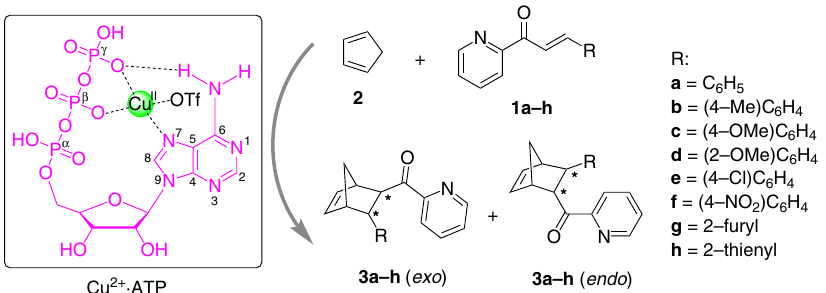
Fig. 1 Schematic representation of enantioselective Diels – Alder reactions catalysed by a Cu(II)-ATP complex. The Cu(II) – ATP complex (Cu 2 + ·ATP) is composed of copper(II) tri fl uoromethanesulfonate (Cu(OTf) 2 ) and ATP. The coordination structure of Cu 2 + ·ATP is supported by spectroscopic characterisations and theoretical calculations, in which Cu 2 + ion binds to one nitrogen atom (N7) from adenine, one oxygen atom from β -phosphate,